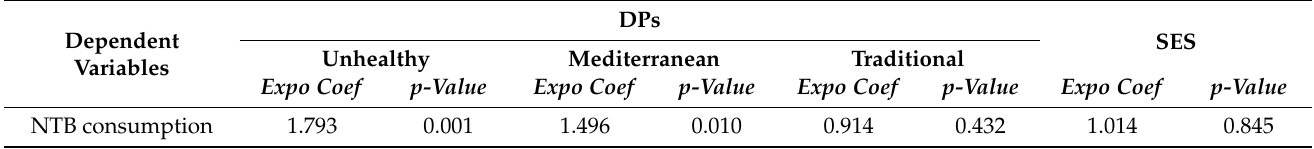
Table 6. Binary logistic regression weights and significances for predicting NTB consumption.